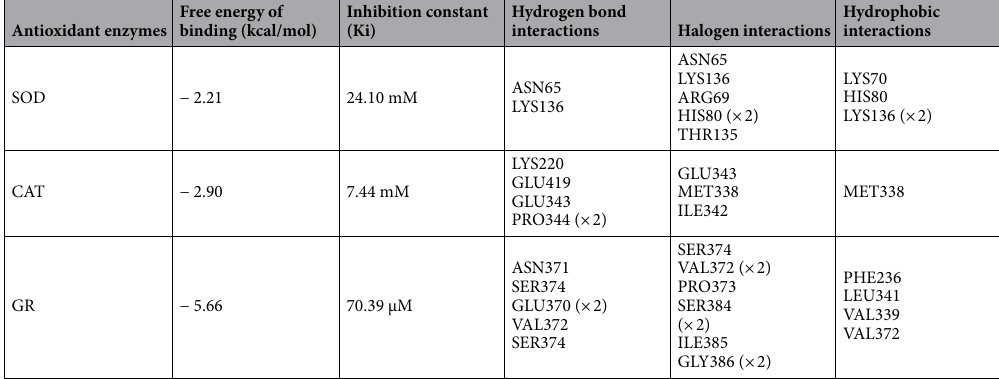
Antioxidant enzymes